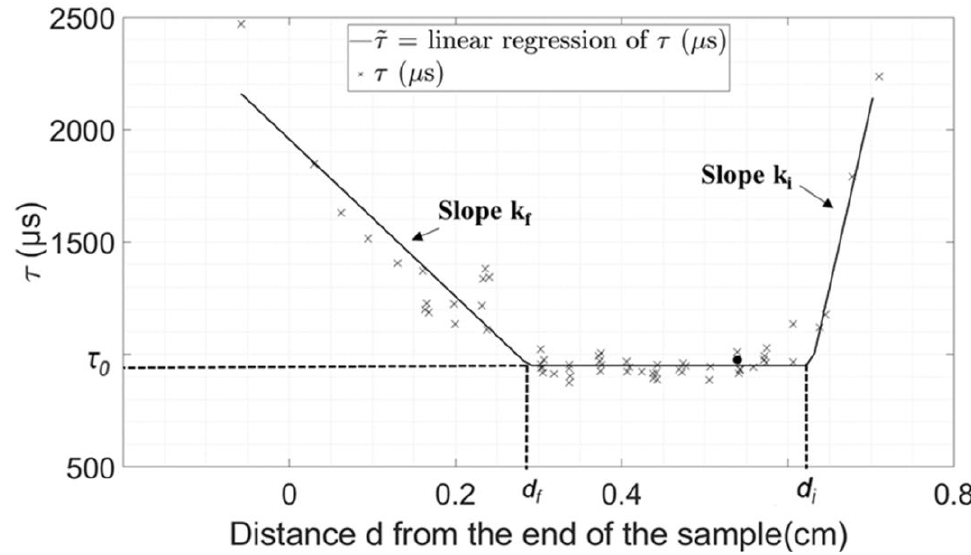
Figure 5. Variation of τ as a function of the distance from the end of the sample ( d ) obtained with a trabecular bone sample. The linear by part interpolation 𝜏̃ obtained using the minimization procedure is shown by the solid line. The signal indicated by a circle is the signal shown in Figure 3. Table 1. Values of τ 0 , d i , d f , k i , k f and E τ (the minimum value of e τ ) corresponding to the linear by part regression analysis 𝜏̃ (see Equation (2)) obtained with the minimization procedure for the samples shown in Figures 4 and 5.